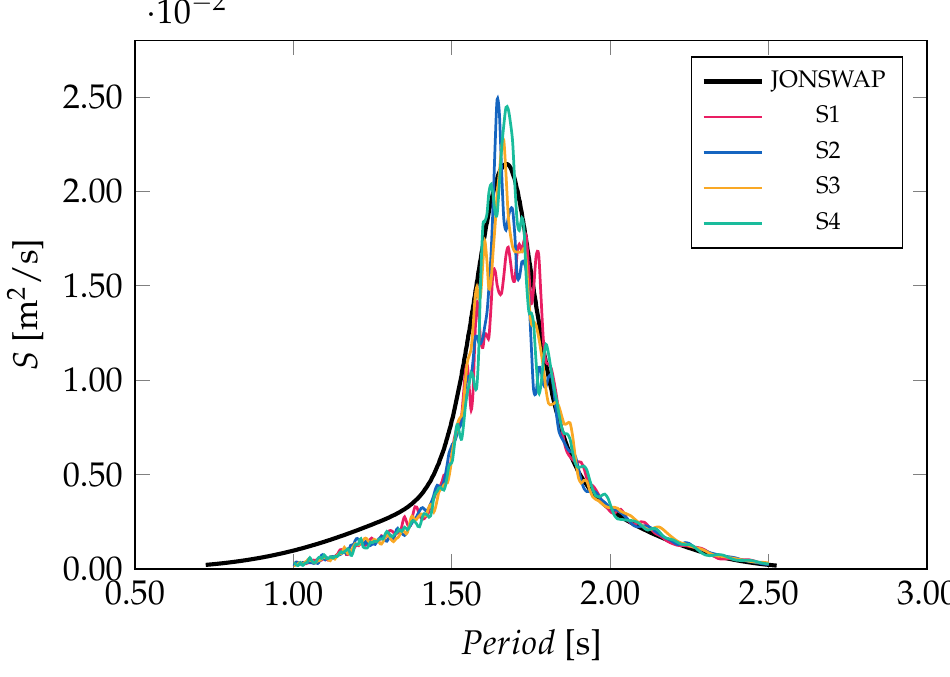
Figure 8. Comparison of the experimental and analytical spectral density (JONSWAP) of the surface elevation in the generation of irregular waves for the four realizations S1–S4 . The waves are measured at a TLP side location.